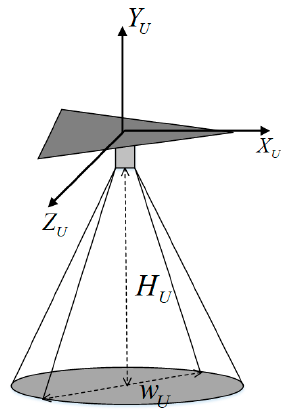
Figure 1. Body/dynamic system and airborne sensor of UAV.